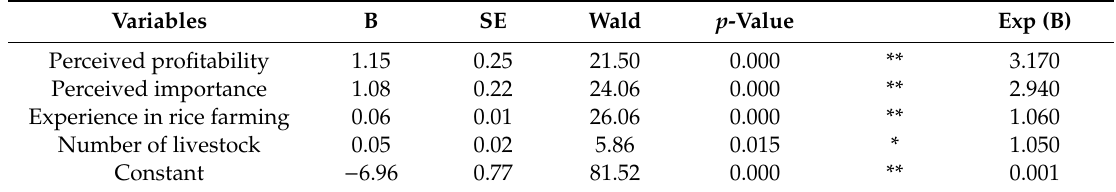
Table 8. Technical factors a ff ecting the adoption of improved cultivars among rice growers of Rudsar